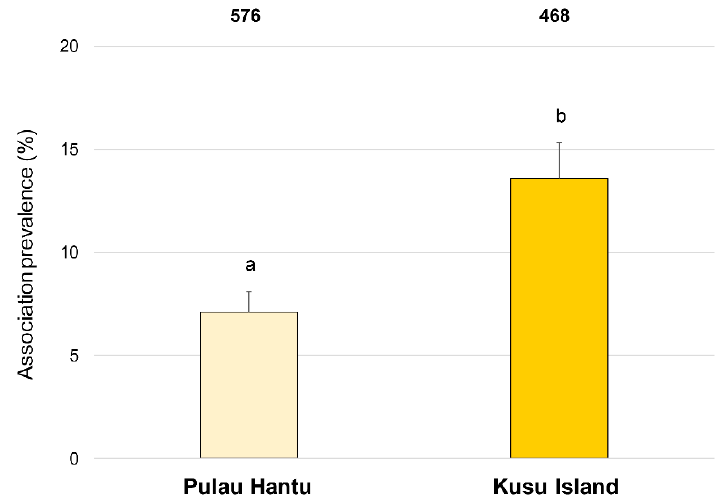
Figure 3. Prevalence (%) of Waminoa sp.–corals associations in Pulau Hantu and Kusu Island. Numbers above each bar indicate the total number of coral colonies (both with and without Waminoa ) analyzed per site. Data are expressed as the mean ± SEM. One-way ANOVA was performed between sites. Letters on the bars denote significant difference among sites. Different letters indicate significant difference ( p < 0.05), while same letter indicates no significant difference ( p ≥ 0.05).